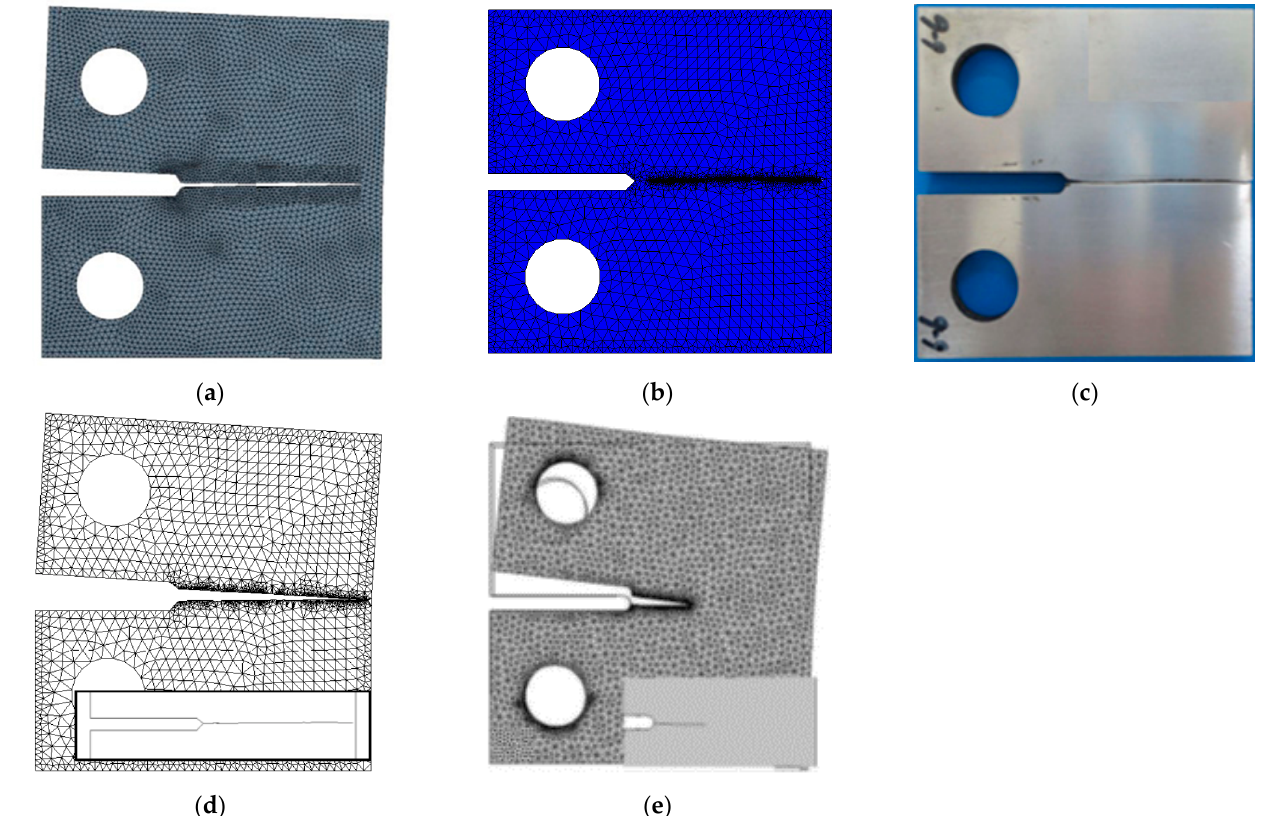
Figure 4. Predicted crack growth path for G1 specimen ( a ) ANSYS Workbench, ( b ) FRANC2D/L and ( c ) Experimental [32], ( d ) numerical [33], ( e ) FRANC3D [32].